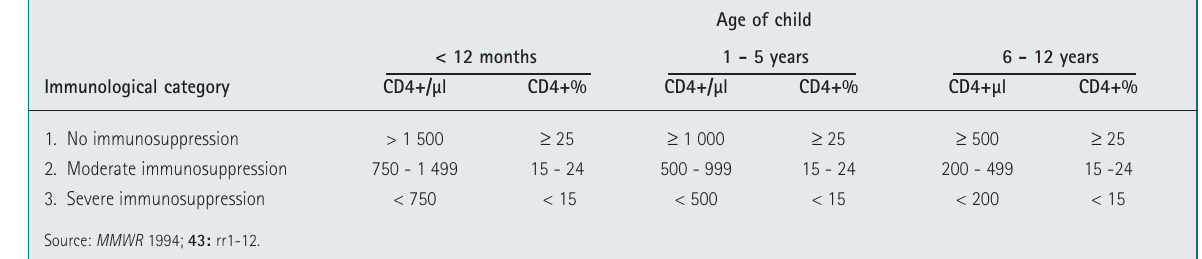
TABLE ll. IMMUNOLOGICAL CATEGORIES FOR CHILDREN WITH HIV INFECTION